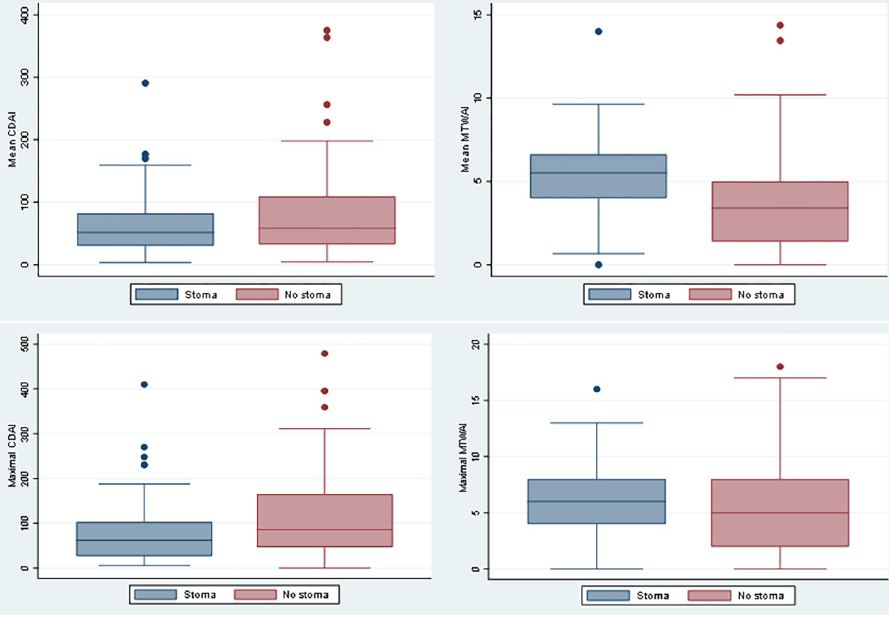
Fig 1. Comparison of mean and maximal Crohn’s Disease Activity Index (CDAI) and Modified Truelove and Witts Activity Index (MTWAI) in patients with and without stoma.